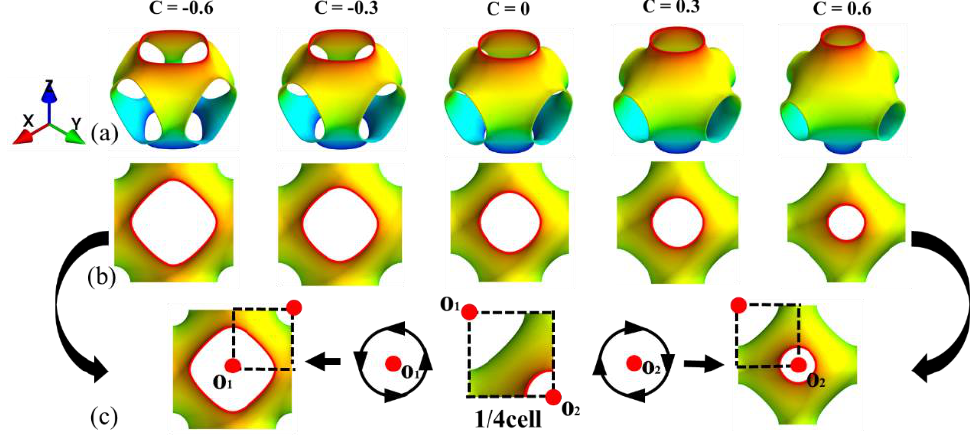
Figure 2. Unit cell geometric configuration of Schwarz’ P surface: ( a ) The 3D schematic of P-TPMS structure; ( b ) the vertical view of P–TPMS structure; ( c ) two formation methods of the surfaces with │ C │ .